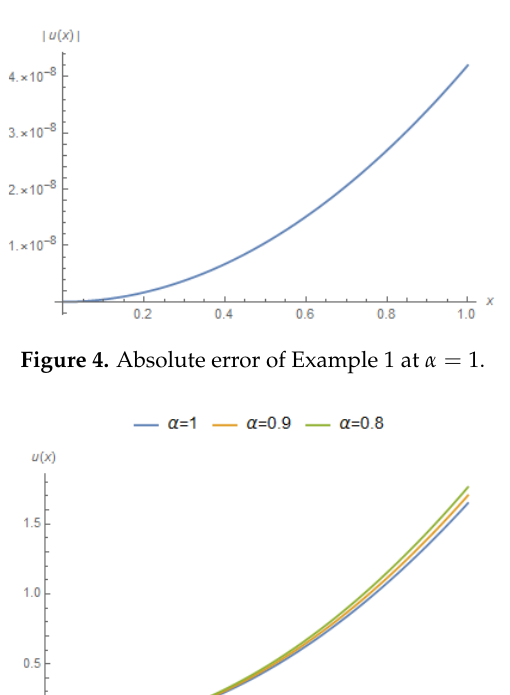
Figure 1:3D exact Solution of example1 with (cid:11) = 1